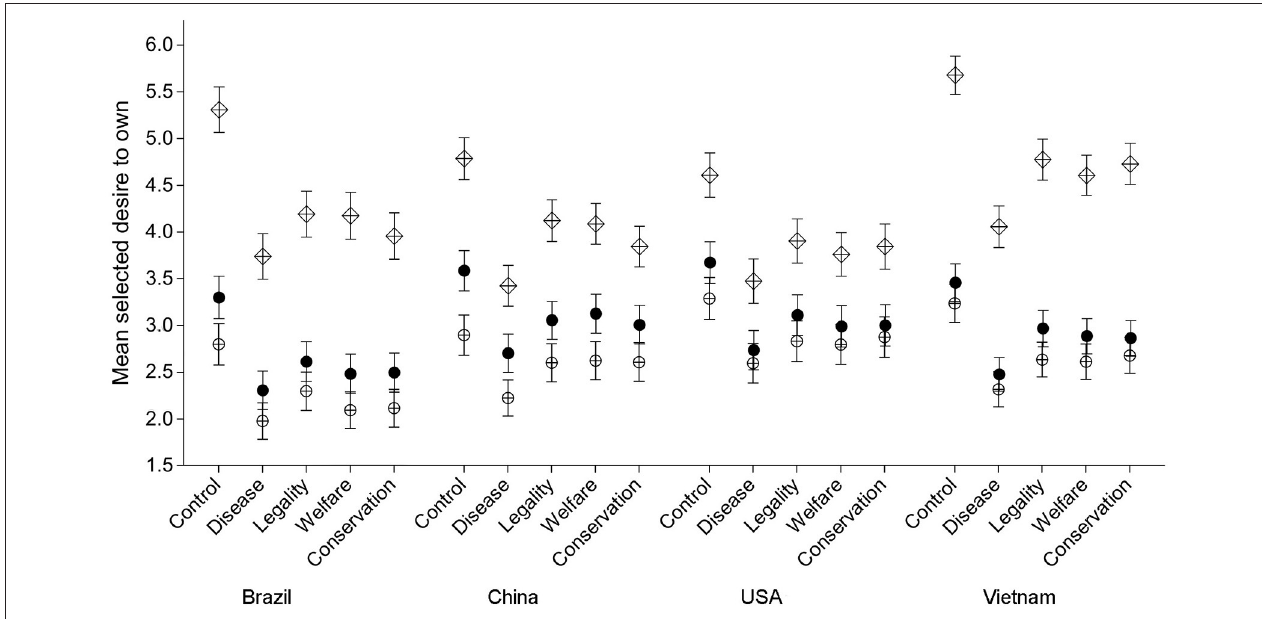
FIGURE 2 | The mean desire to own a given pet, on a 1–10 scale, of respondents from each country, given each type of experimental treatment, for birds (open rhomboid symbols), mammals (closed circle symbols), and reptiles (open circle symbols). Error bars represent standard